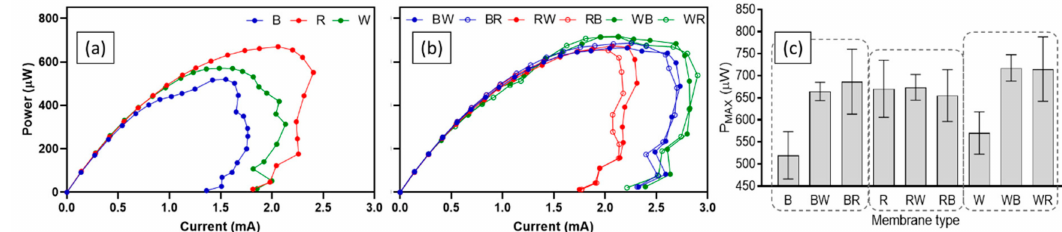
Figure 5. Power curves and P MAX of MFCs with test ceramics; single composition ceramics ( a ), spotty ceramics ( b ), and P MAX from each power curve ( c ). Data represent average values from triplicates of each ceramic type, and error bars of power curves are not shown for